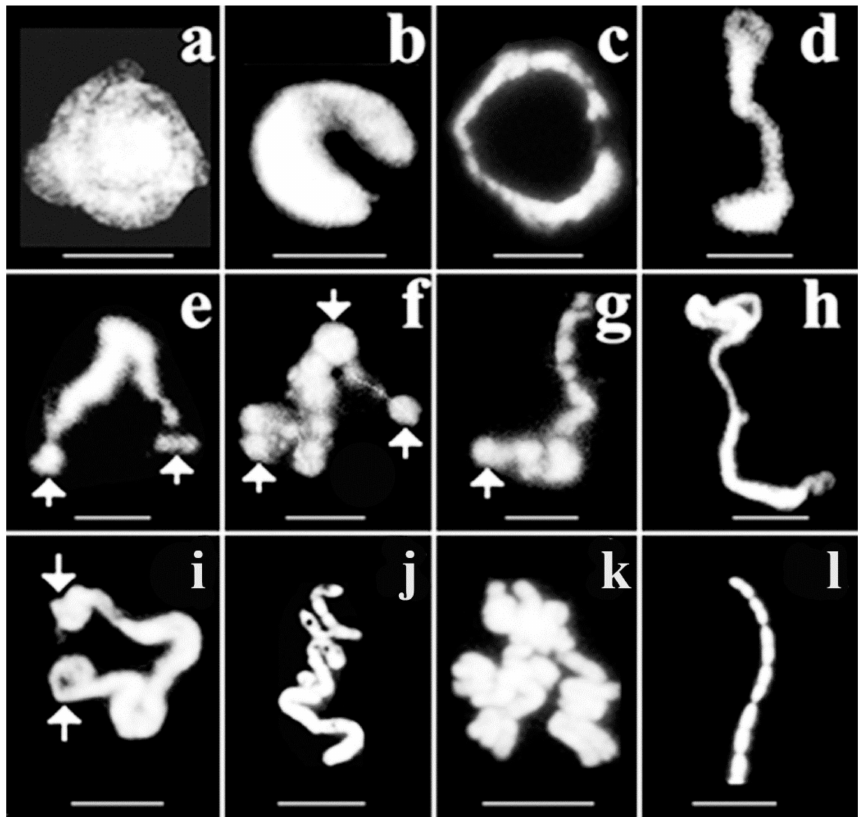
Figure 6. Linear connection of interphase chromosomes in condensing chromatin. Chinese hamster ovary cells were kept in suspension culture in spinner flasks. Exponentially growing cells were synchronized by elutriation and eight fractions were collected. Details of cell growth, synchronization, FACS analysis, reversal of permeabilization, isolation of nuclei, spreads of nuclear structures and visualization of chromatin structures were carried out. CHO chromosomes are synchronized by centrifugal elutriation representing different stages of the cell cycle. Condensing chromosomes were selected from the multitude of forms that were characteristic of the cell cycle they belonged to. Reversible permeabilization, isolation of nuclei, spreads of nuclear structures and immunofluorescent visualization of interphase and metaphase chromosomes were described in [83]. ( a – d ) Opening CHO-K1 nuclei forming semicircular linear chromatin. ( e – g ). Formation of interphase chromosomes indicating the clustering inside the chromatin. ( h , i ) chromatin ribbon turning to zig-zag arrangement of elongated chromosomes. ( j , k ) Pre-condensed chromosomes. ( l ) Linearly connected metaphase chromosomes. Bars, 5 µ m each. Modified with permission from Ref. [30]. Copyright year 2009, Springer, Dordrecht. Figure 3.17 of this